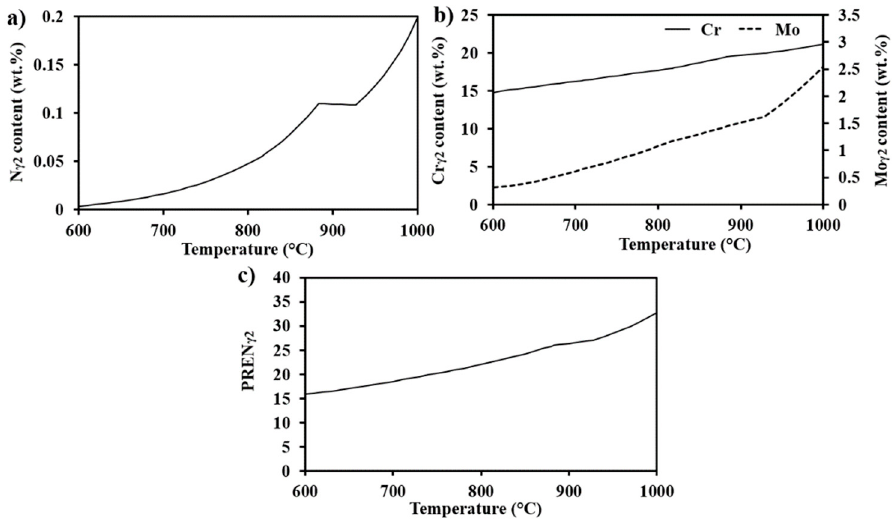
Figure 15. Calculated equilibrium contents of ( a ) N, ( b ) Cr, and Mo in secondary austenite precipitating at different temperatures and ( c ) the resulting PREN.